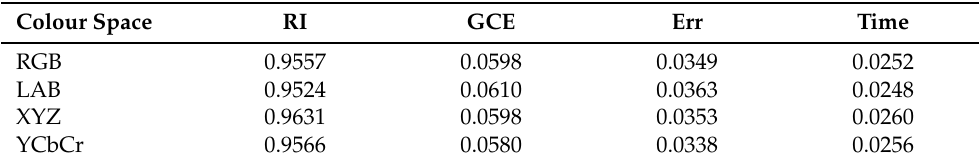
Table 3. Performance measures for the proposed procedure with respect to the chosen colourspace. The performance measurements are the same described in Section 3.2. The computational time is measured in seconds.